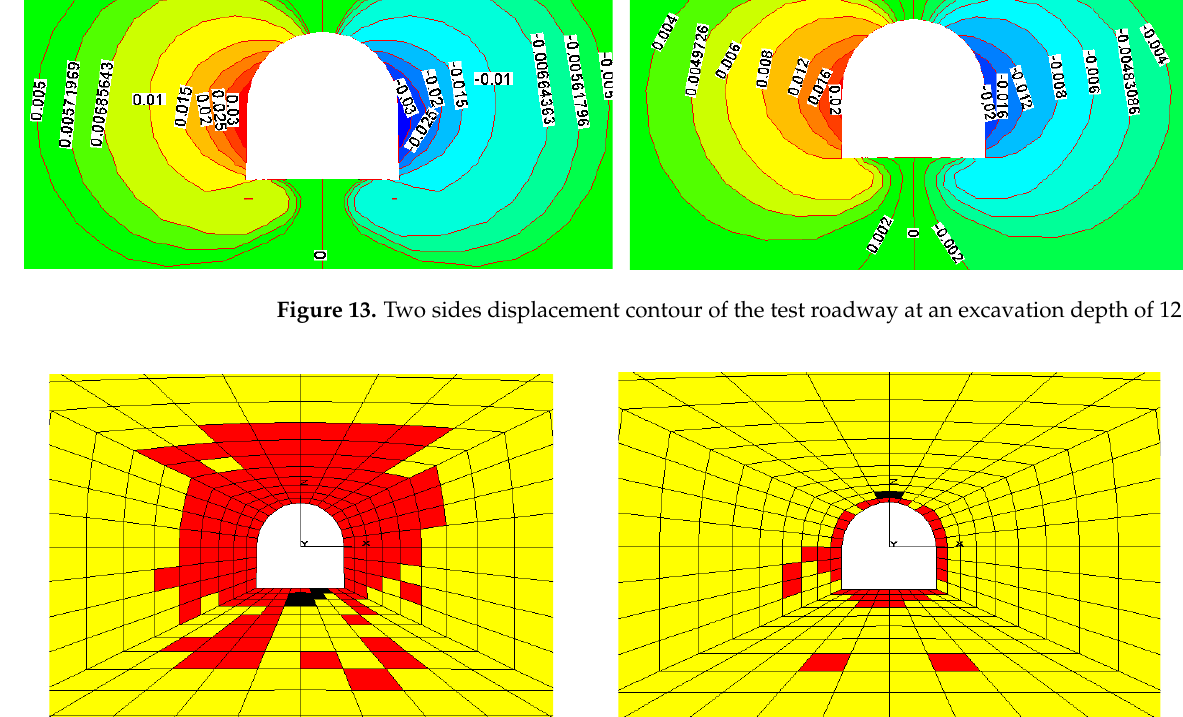
Figure 14. The plastic yield zone of roadway surrounding rock at an excavation length of 12 m